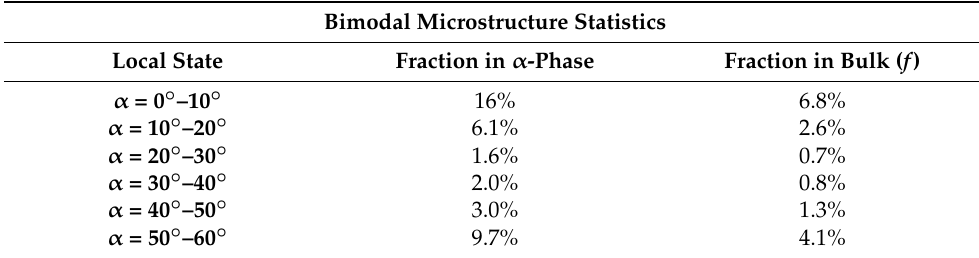
Table 1. Fraction corresponding to each of the binned regions of the primary a phase, and the corresponding volume fractions of all constituents in the bulk